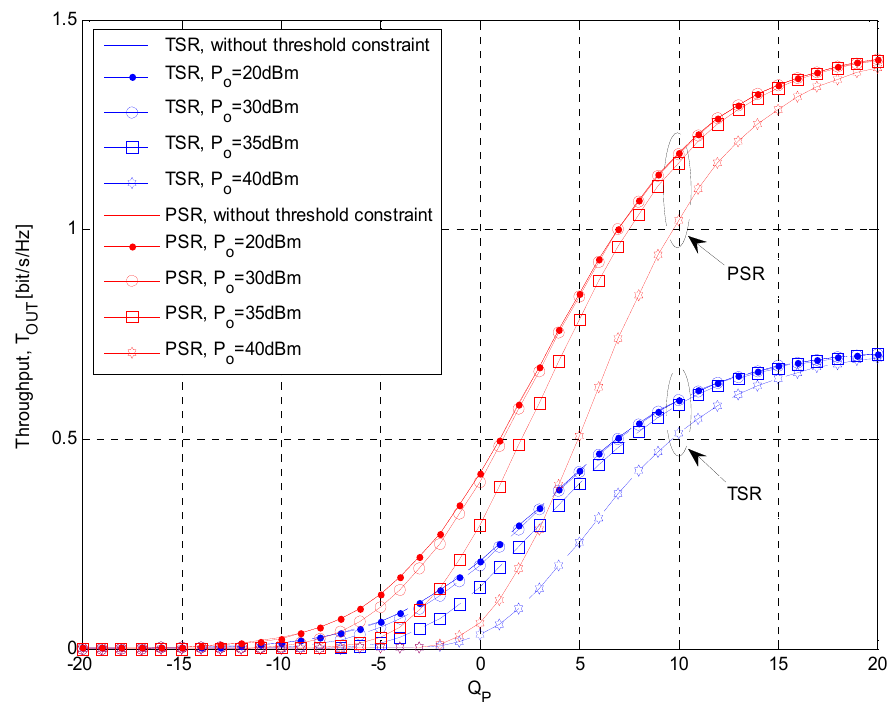
Figure 9. Simulation results for the achievable throughput vs. interference threshold Q p and mini- mum threshold constraints of the input power at the SR, P o.